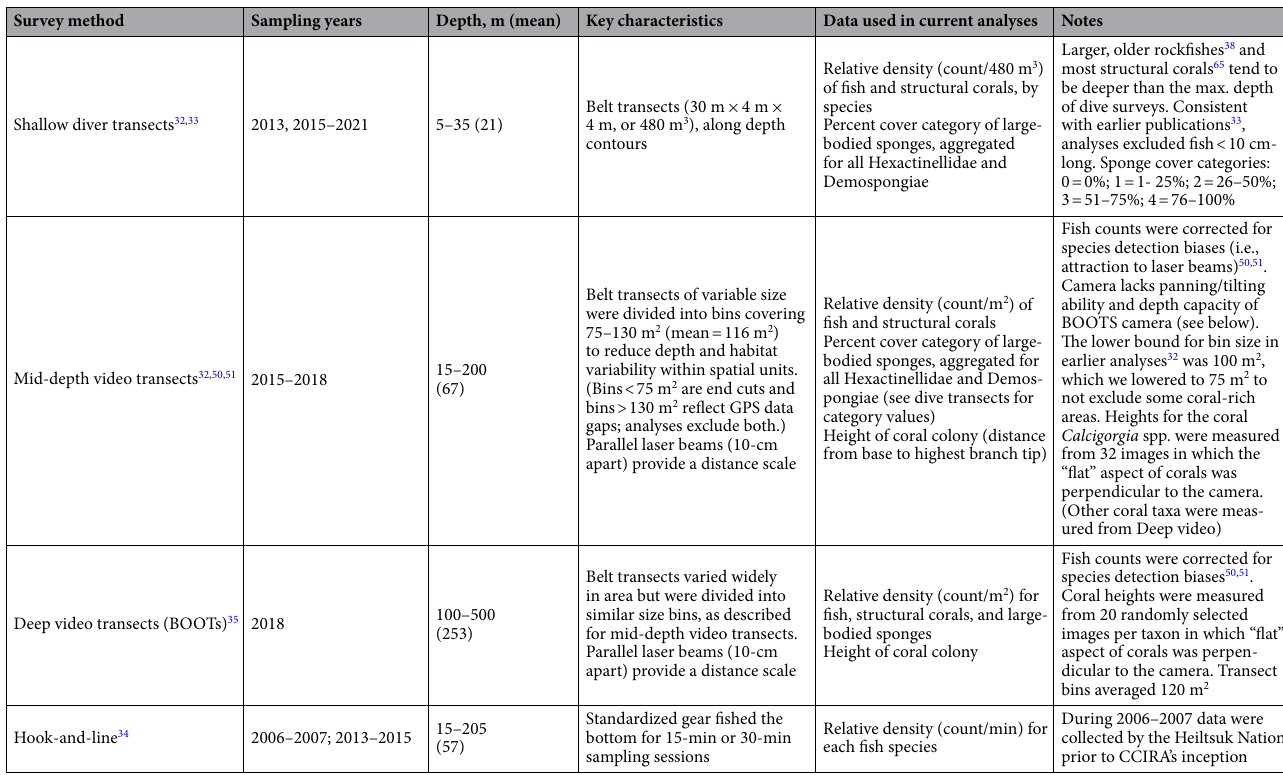
Table 1. Survey methods used for data collection. For full description of each method and its suite of data, see references in first